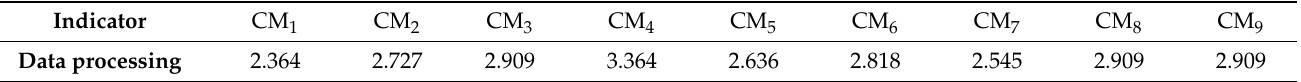
Table A14. Data processing of construction management risk